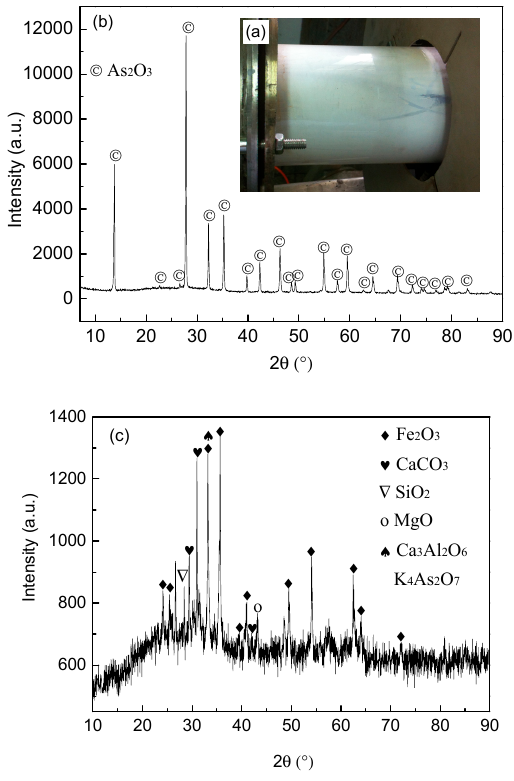
Figure 9. ( a ) Volatile compounds photograph, ( b ) XRD spectrum of volatile compounds collected during roasting dust ash, and ( c ) the dust ash after roasting.